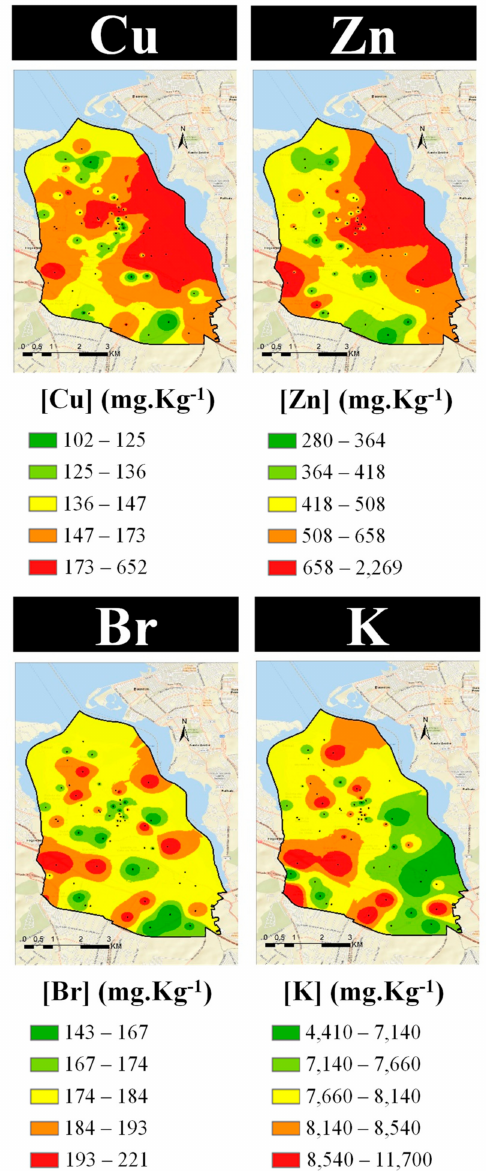
Figure 12. Spatial distribution of elements related to an anthropogenic origin, namely from road traffic ( top ) and biomass burning ( bottom